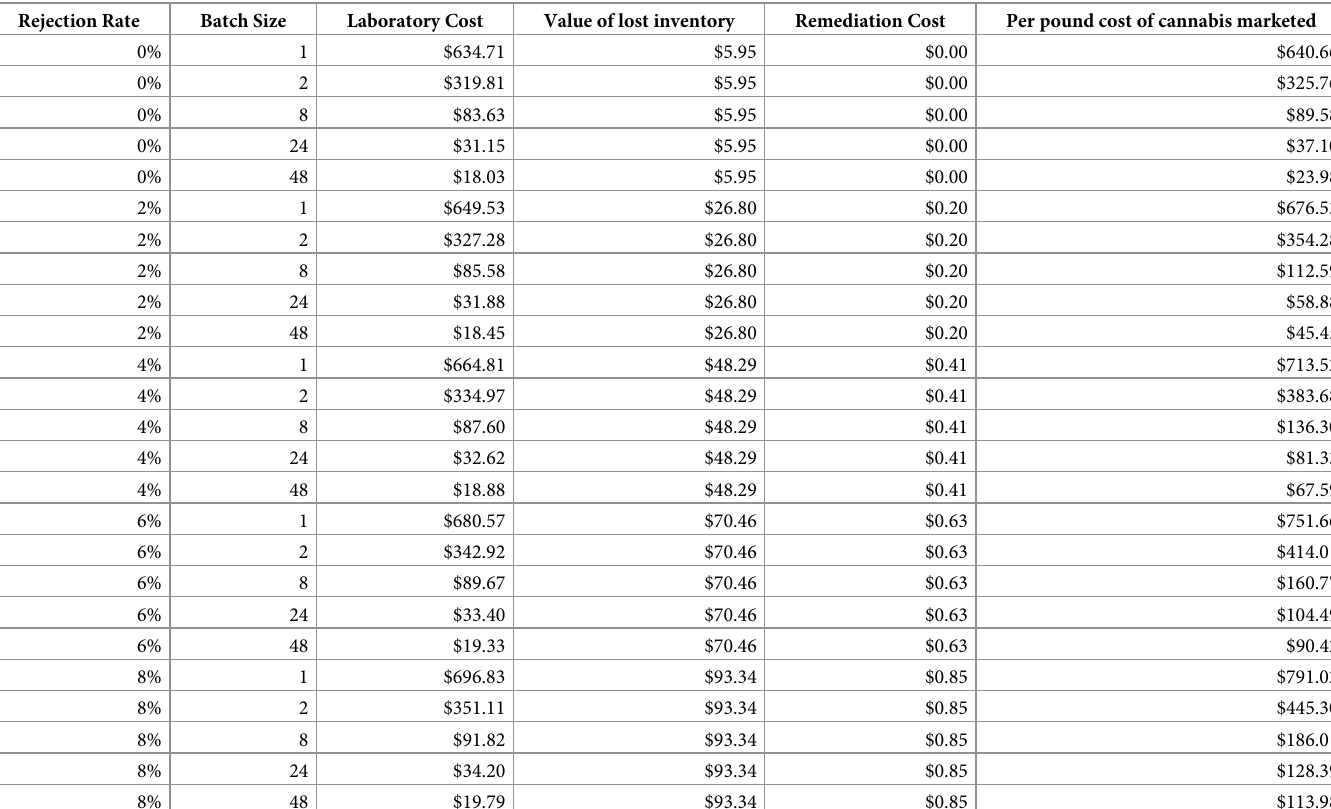
Table 7. Itemized costs per pound of cannabis that reaches the market at three rejection rates and different batch